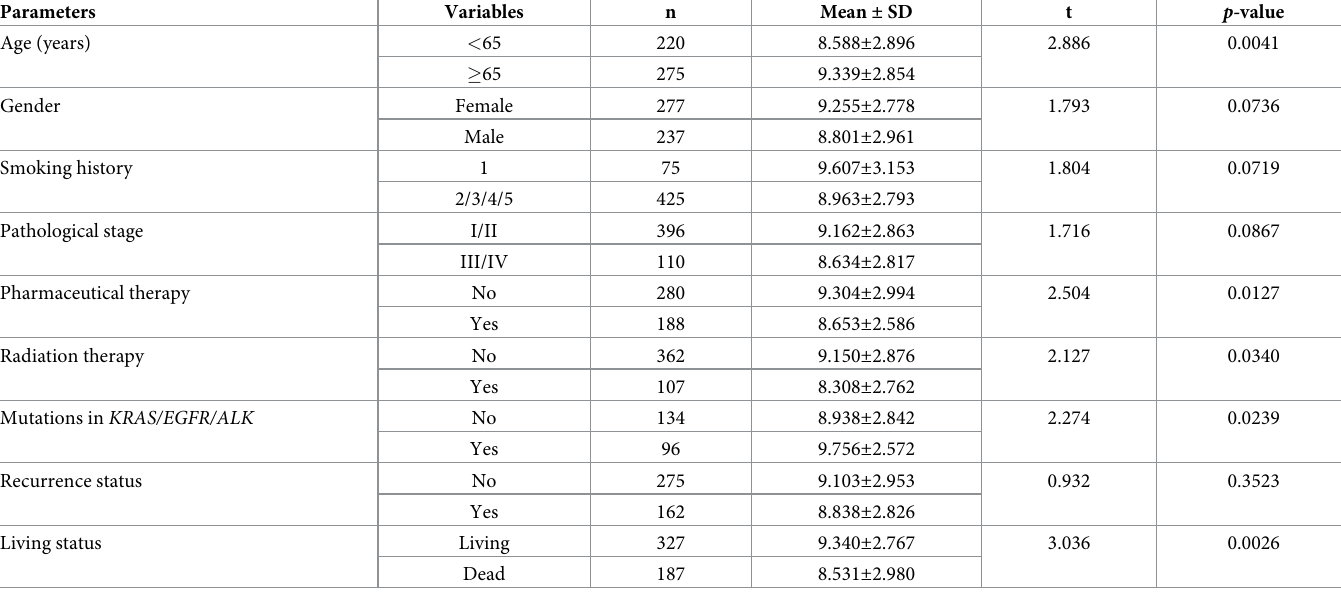
Table 1. Correlation between the clinicopathological parameters and CYP4B1 expression in LUAD.